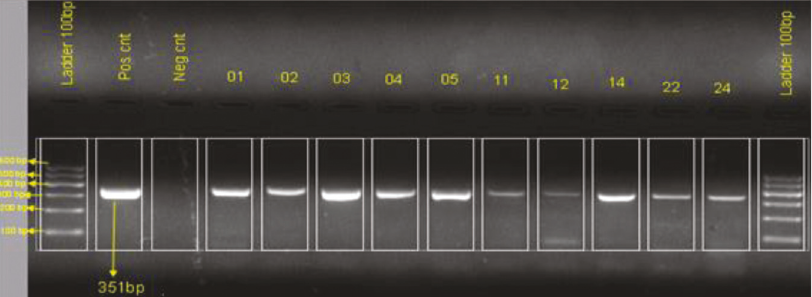
Figure 3: Conventional PCR-amplified products of 10 positive samples showing a band size of 351 bp of viral N gene (from left to right).